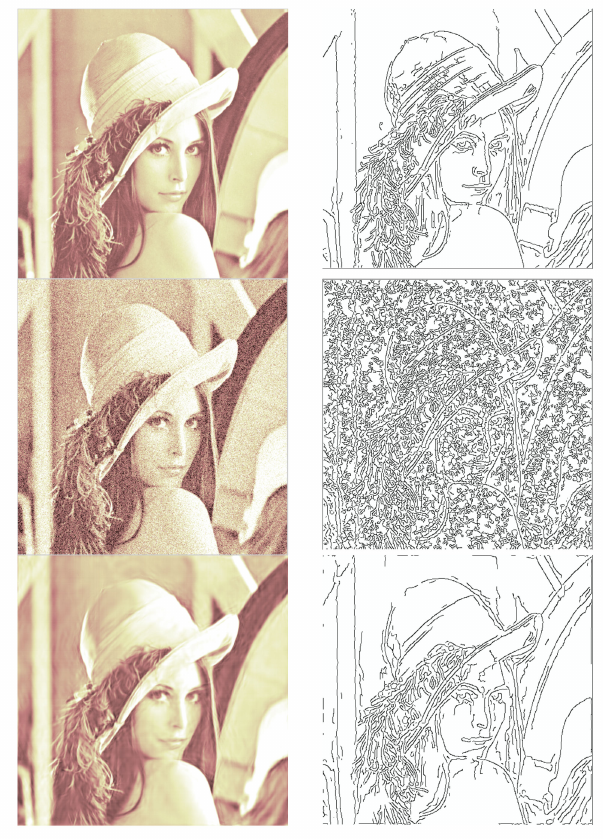
Figure 2. Comparison of results obtained — σ n = 30. First line: original image and its edge map obtained with Canny’s detector; second line: noisy image and its edge map obtained by applying Canny’s detector; third line: denoised image and the result of the proposed method.